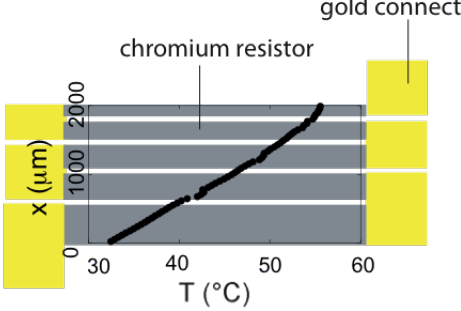
Figure 20. Top view of an output resistor geometry obtained performing shape optimization, made of chromium resistors (in gray) and gold connectors (in yellow). The experimental temperature profile along the cavity shows a linear dependence of the temperature with the x-axis.